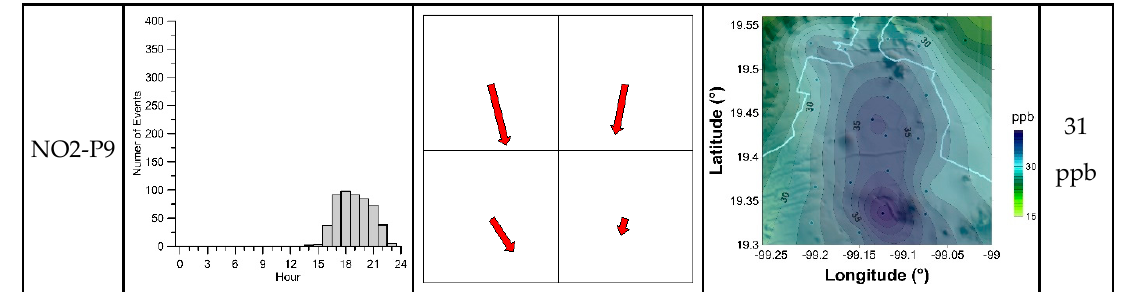
Figure 9. Flow patterns of nitrogen dioxide in the Mexico City region during the period 2001–2010. For each pattern, we included the hourly population (second column), the mean flow vectors (relative to the pattern) at the city quadrants (third column), the surface concentration distributions (fourth column) averaged over the events of the flow pattern, and the mean spatial concentration (last column). The size of red arrows that stand in for the NO 2 flow vectors indicates the flow intensity in a scale relative to the edge size of the squares that represent the quadrants.